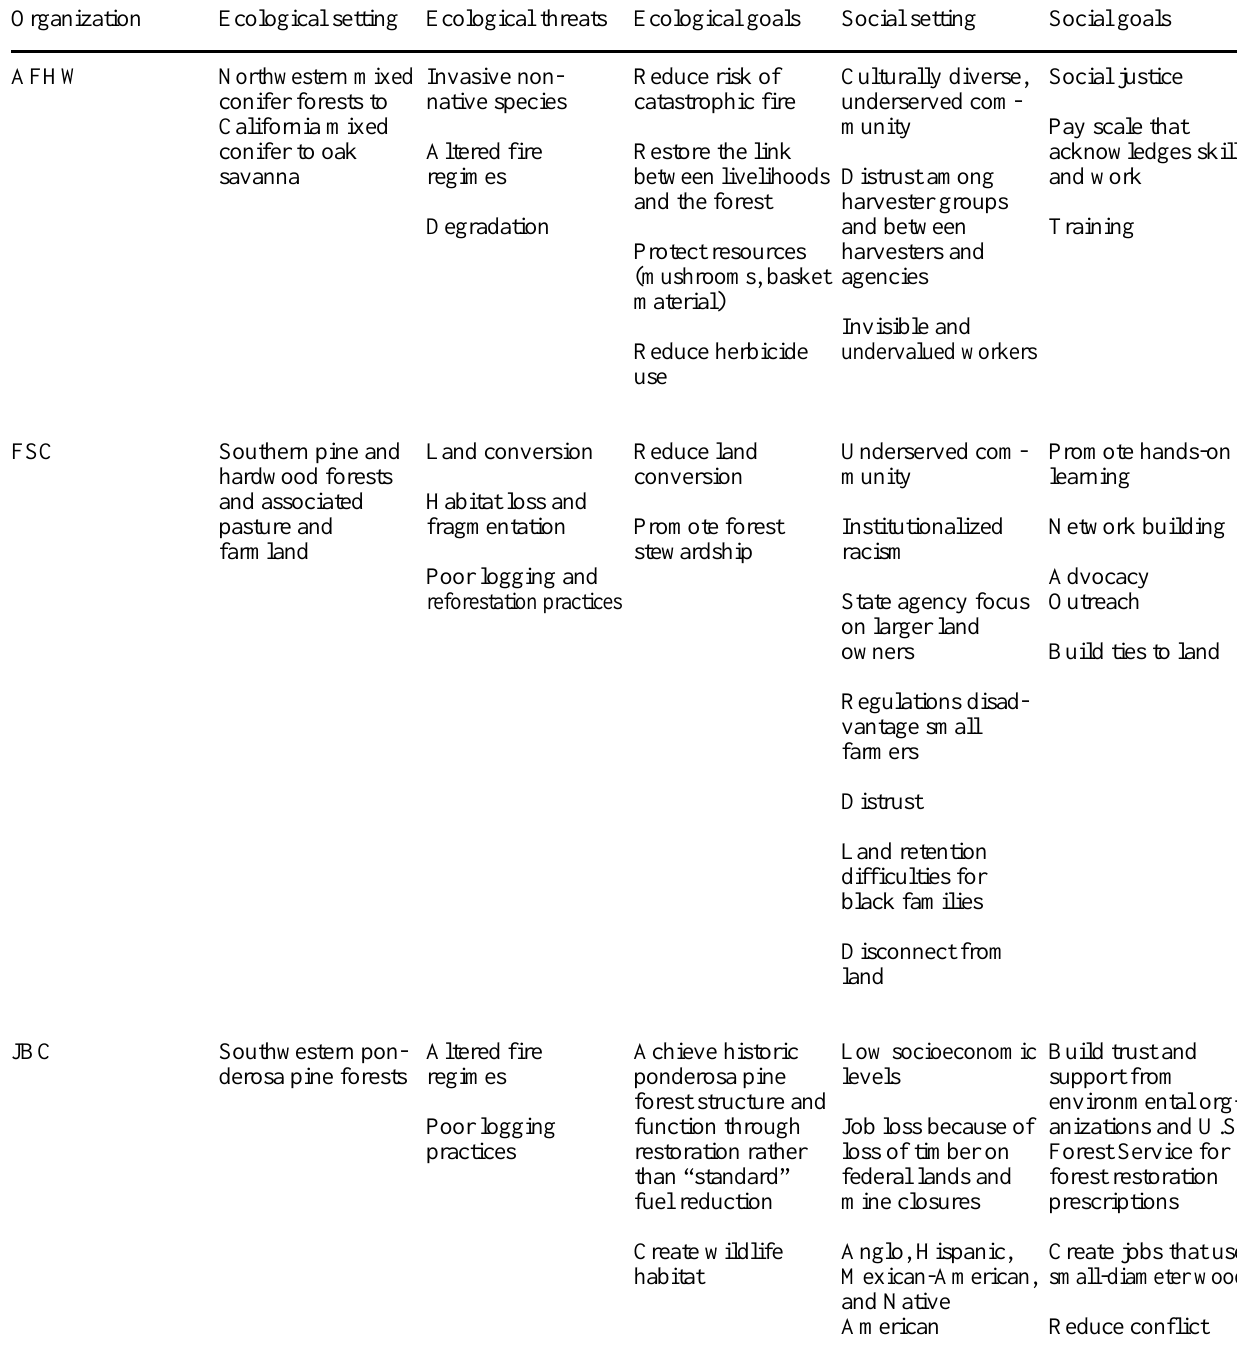
Table 1. Overview of the ecological and social settings and objectives of the seven community-based forestry groups